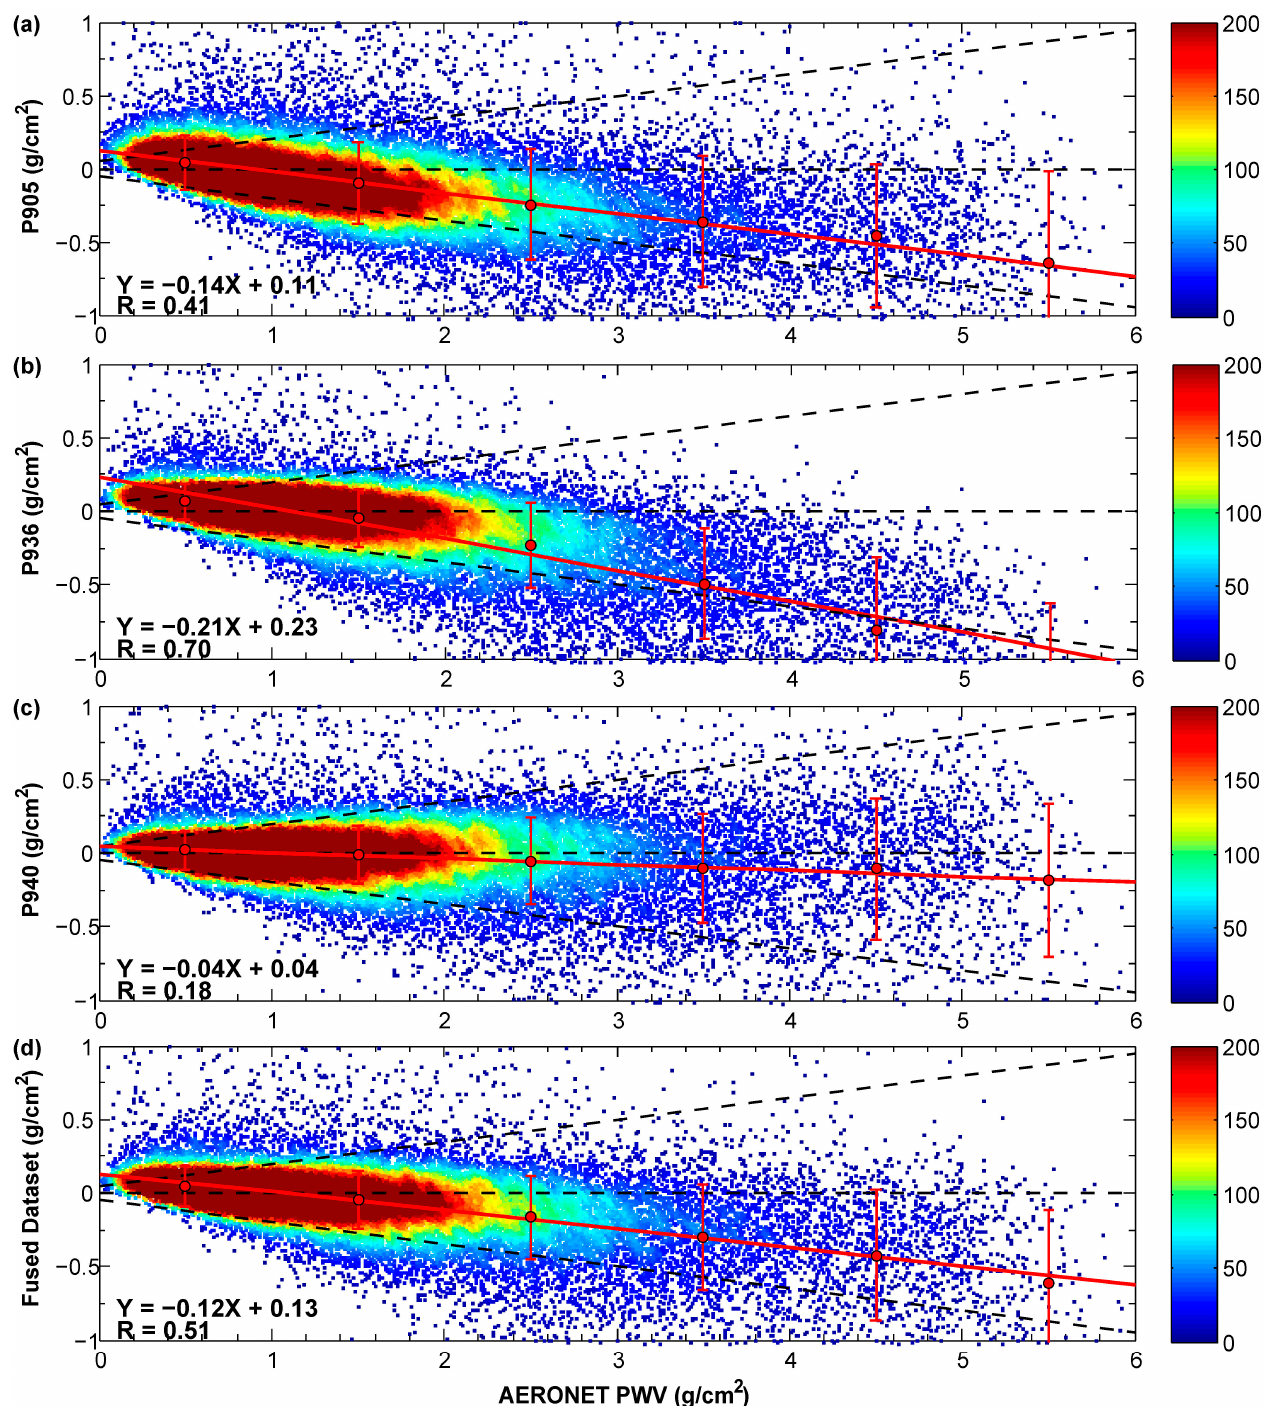
Figure 4. Error distributions of four MERSI-2 PWV datasets: ( a ) MERSI-2 P905 PWV dataset; ( b ) MERSI-2 P936 PWV dataset; ( c ) MERSI-2 P940 PWV dataset; ( d ) fused MERSI-2 PWV dataset. The dashed lines on both sides are the envelope of PER15. The red line is the linear regression line. The color of each point represents the density of the point where the point is located.